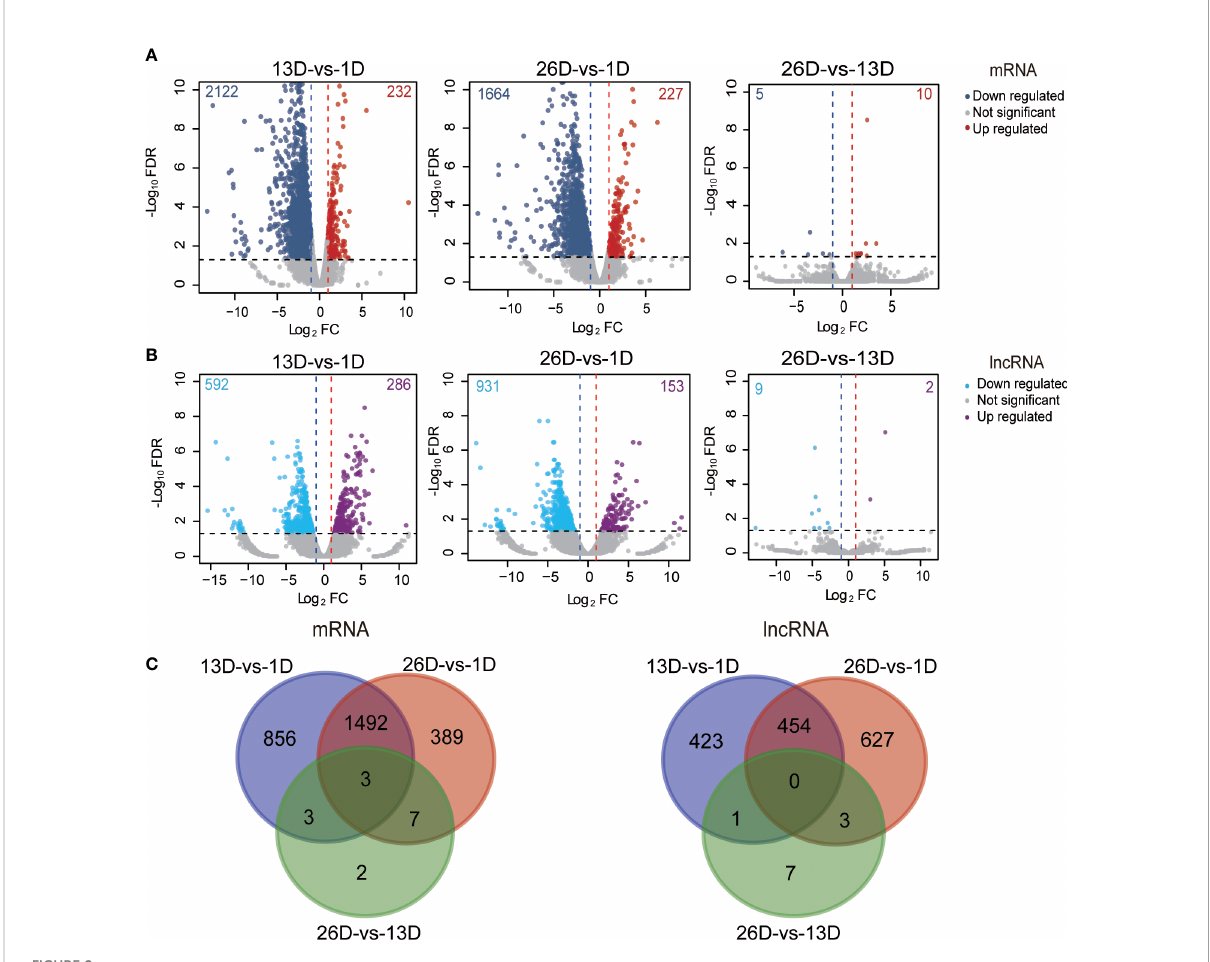
FIGURE 2 Differentially expressed mRNAs and lncRNAs during squab BF development. (A-B) . Volcano plot of the DE mRNAs(A) and lncRNAs (B) between two different development stages. The x-axis indicates the difference in expression level on a log2 (fold change). The y-axis represents the corresponding false discovery rate on a negative log 10(FDR). (C) . Venn plot shows the number of overlapping DE mRNAs and lncRNAs in different developmental